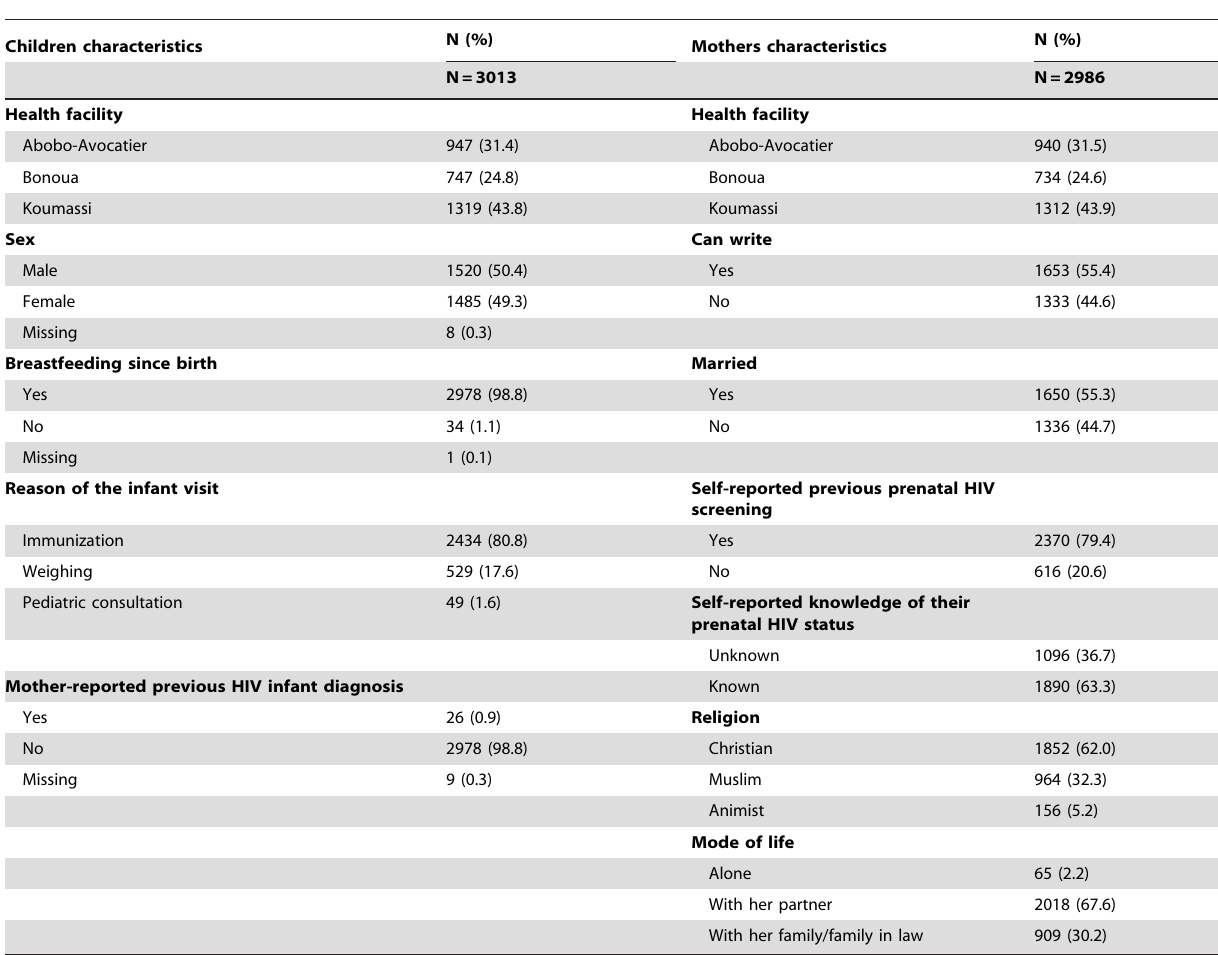
Table 1. Children (n=3013) and mothers (n= 2986) characteristics at inclusion.